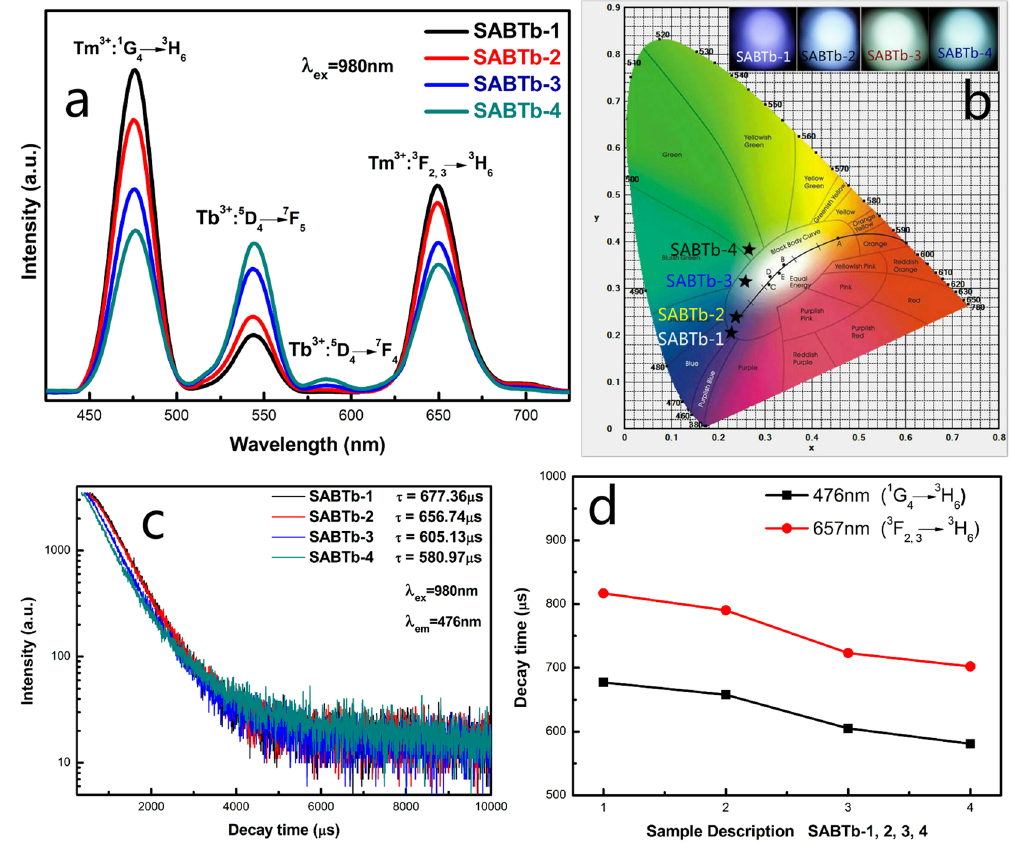
Figure 5. ( a ) The UEC emission spectra of SABTb-1, SABTb-2, SABTb-3 and SABTb-4 glass-ceramics under 980 nm excitation. ( b ) CIE (X, Y) coordinate diagram showing chromaticity points of Tb 3 + and Tm 3 + luminescence in the glass-ceramics. ( c ) Fluorescence decay curves of Tm 3 + ions at 476 nm in the SABTb glass- ceramics under 980 nm excitation. ( d ) Decay behavior of 5 D 4 , 1 G 4 and 3 F 2,3 levels for the SABTb